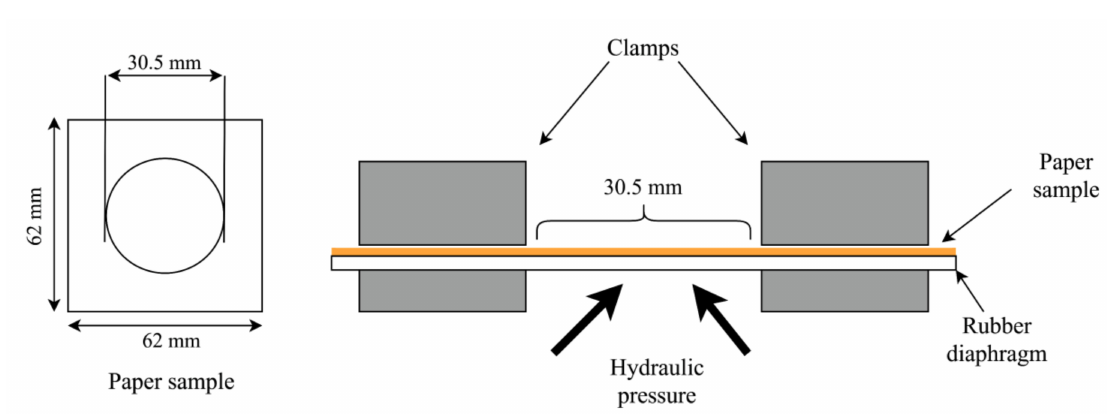
Figure 12. Burst strength